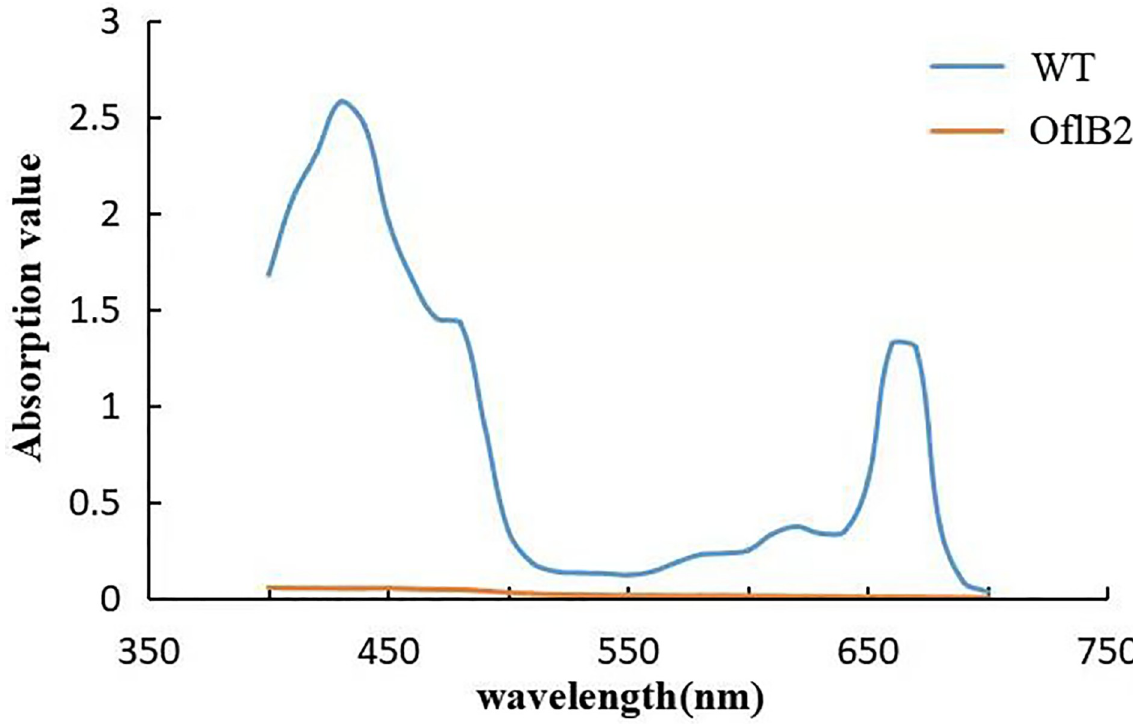
Fig 2. The absorption spectrum of the pigments in WT E . gracilis and OflB2.